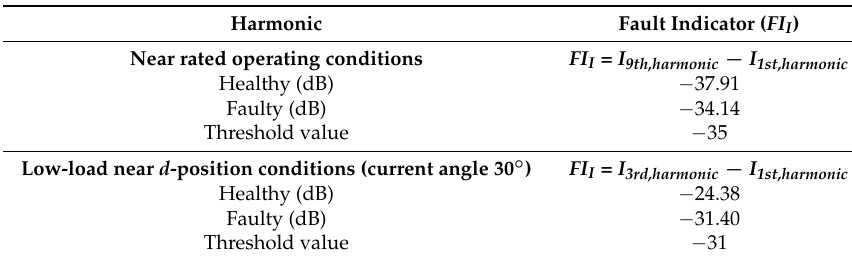
Table 4. Eccentricity fault indicator of the analyzed fPMa-SynRM based on the stator currents harmonics.